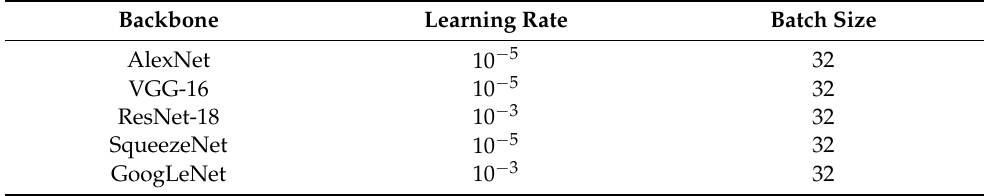
Table 1. Hyperparameters of the developed